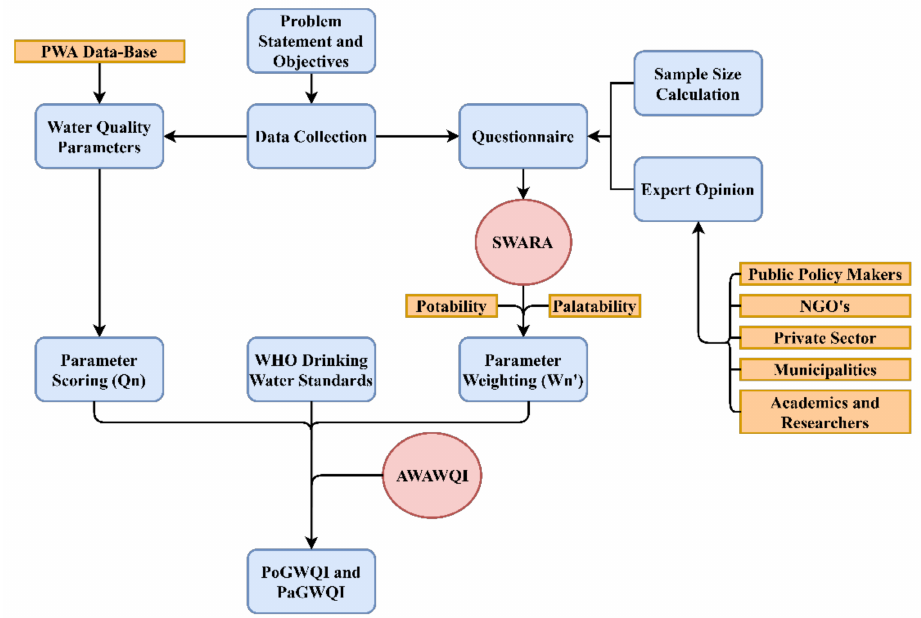
Figure 2. Development of potability and palatability groundwater quality indexes (PoGWQI and